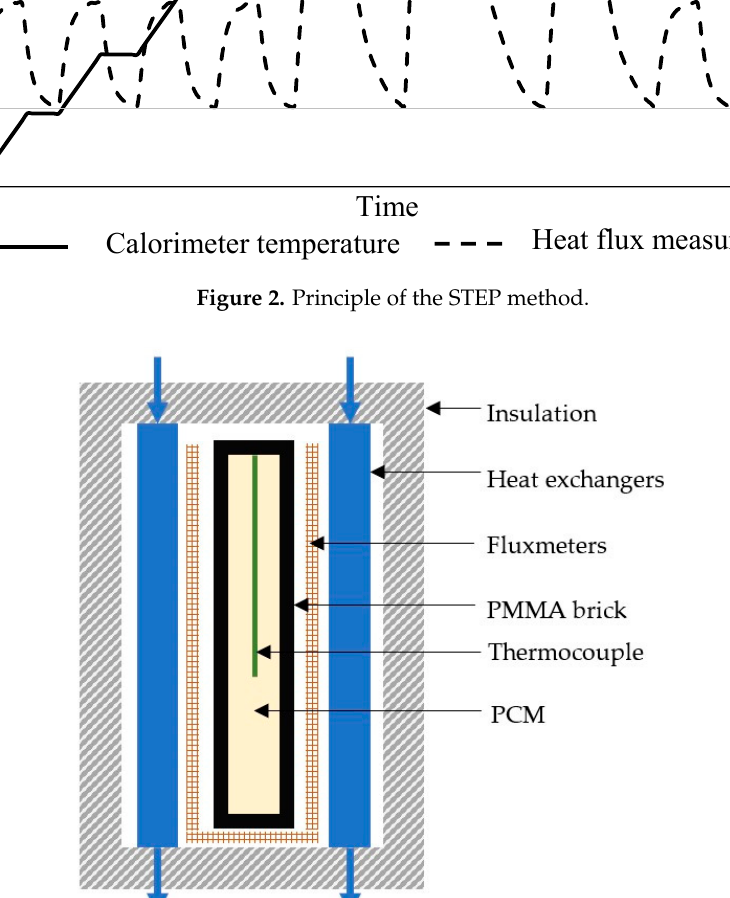
Figure 3. Experimental apparatus of the fluxmeter bench (sectional view).